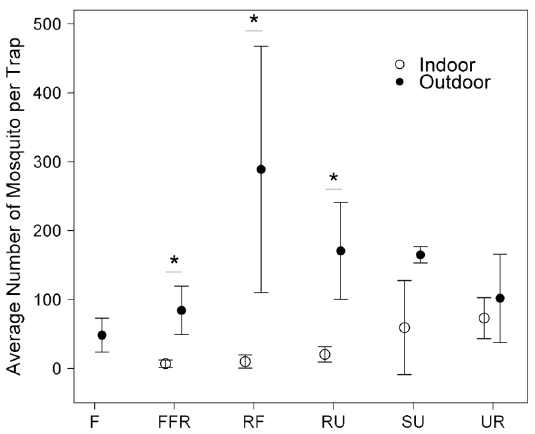
Figure 4. Average number of mosquitoes caught indoors and outdoors per trap and 95% confidence intervals. Mosquitoes were caught in the forest (F), fragmented forest (FFR), rice field (RF), rural (RU), suburban (SU), and urban (UR) habitats in Nakhon Nayok Province, Central Thailand, during the rainy season of 2008. Each habitat type is represented by four replicate sites, except for the rice field habitat where only three sites were included in the analysis. Wilcoxon-Mann-Whitney rank sum test was used in the analysis. Stars indicates P=0.029. P-value for the suburban and urban habitat were 0.057 and 0.686, respectively.